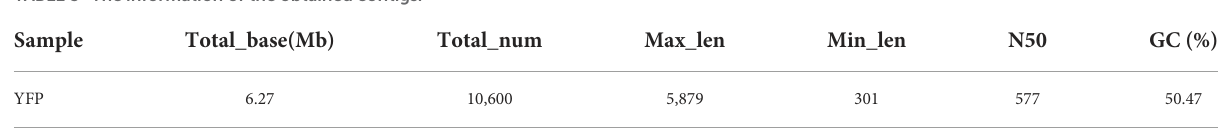
TABLE 3 The information of the obtained contigs.